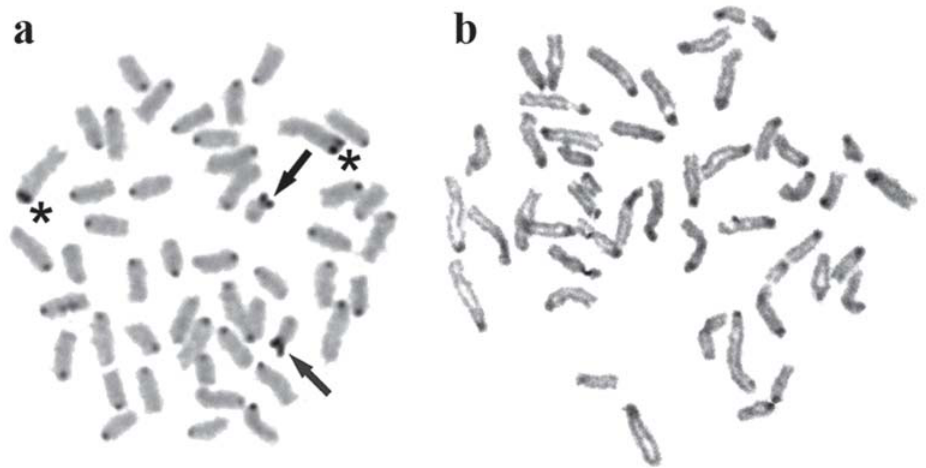
Fig. 2. C-banded metaphases of Rhomboplites aurorubens (a) and Ocyurus chrysurus (b). Arrows indicate chromosome pair 24. Asterisks indicate a large chromosome pair with conspicuous C-positive blocks.